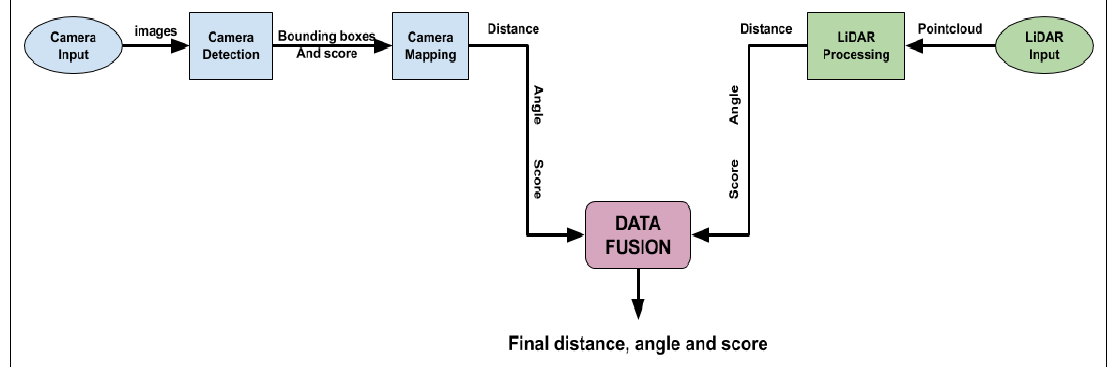
Figure 7. High level block diagram of LiDAR and Camera data fusion